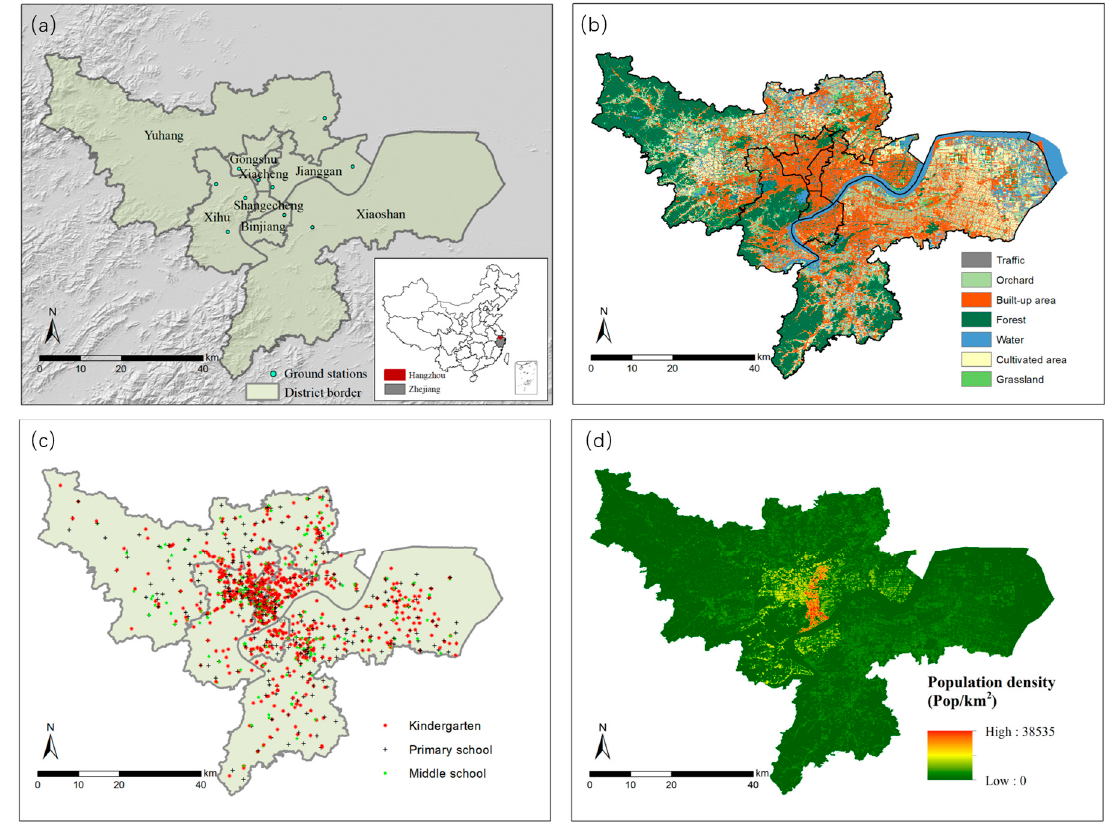
Figure 1. ( a ) Location of the study area and ground monitoring stations; ( b ) Land cover map of Hangzhou in 2015; ( c ) Spatial distribution of kindergarten, primary and middle schools in Hangzhou; and ( d ) Population density on 100 m × 100 m grid map.